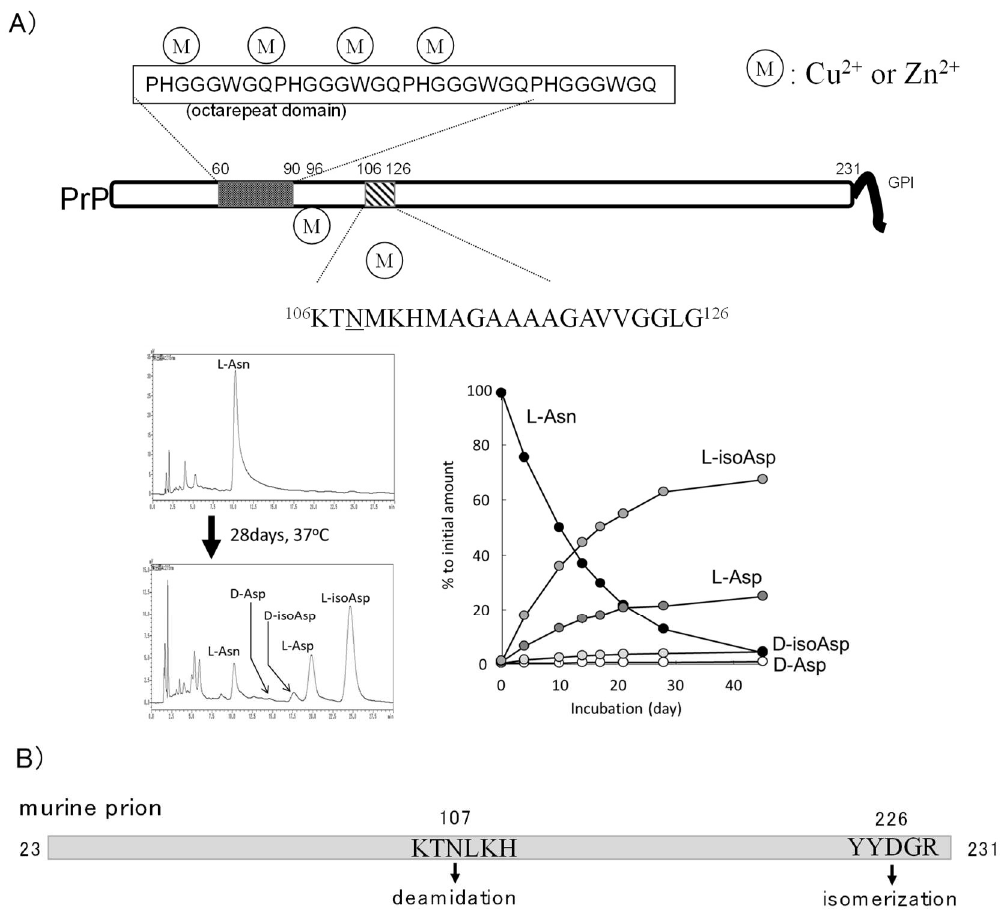
Figure 5. Prion protein structures and analysis of Asn deamidation. ( A ) The structure of PrP C and metal-binding sites. Octarepeat domain and neurotoxic fragments PrP 106–126 are depicted and Asn 108 is indicated by underline. PrP C possesses six metal-binding sites. The PrP 106–126 was analyzed with a mobile phase containing 20% acetonitrile, a 15 mM sodium phosphate solution (pH 5.0), and 100 mM NaCl according to the methods described in [14]. The HPLC profiles after incubation for 28 days at 37 ◦ C in 50 mM phosphate buffer (pH 7.4) and the summarized graph are shown (Y. Sadakane, unpublished data). ( B ) Asn deamidation and Asp isomerization in rodent prion protein are shown [87].